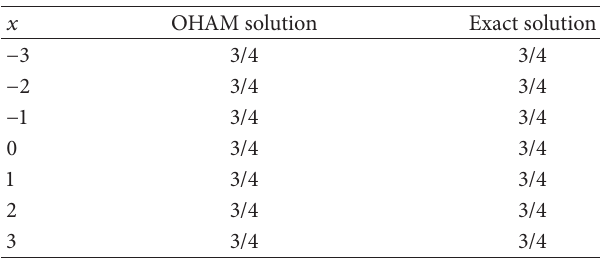
Table 3: Comparison of 𝜇(𝑥,𝑡) solutions obtained by OHAM to the exact solution.